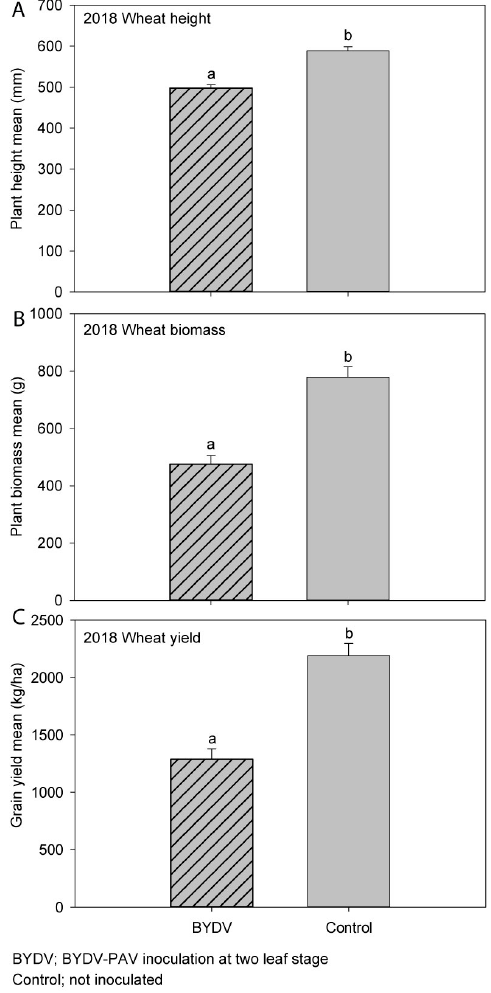
Figure 5. The effect of early (BYDV) or no (Control) BYDV-PAV inoculation on: ( A ) plant height; ( B ) plant biomass; ( C ) grain yield of wheat in experiment 4 (2018) in South-Eastern Australia. Error bars represent standard error; means with the same letter are not significantly different at p < 0.05.